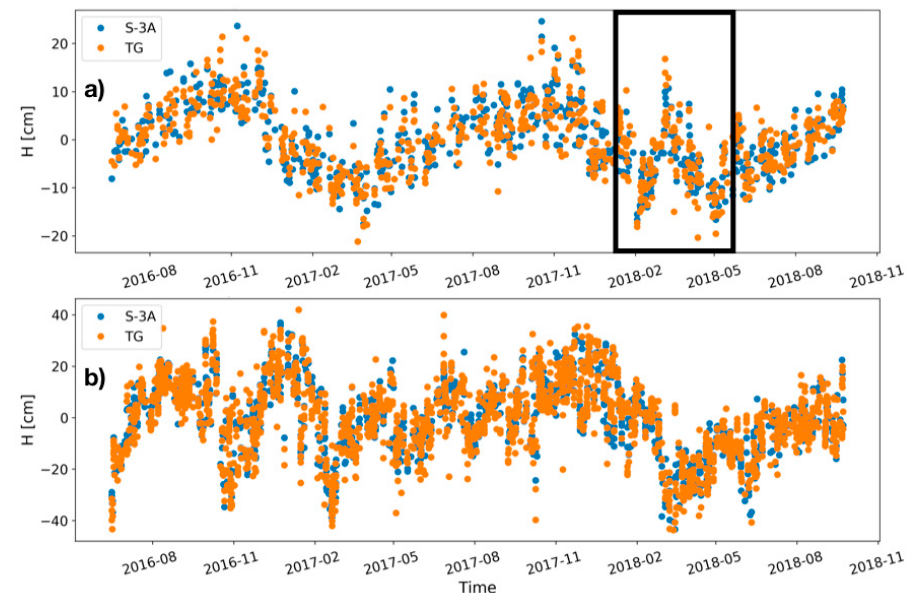
Figure 5. Time series of SLA (cm) obtained from the Sentinel-3A most correlated track points (blue dots) and tidal residuals (orange dots) time series at each station site for ( a ) the Mediterranean basin and ( b ) the Baltic Sea. Black square denotes the time period showing a second maximum in 2018 for SLA. The mean value of each time series has been subtracted for comparison purposes.